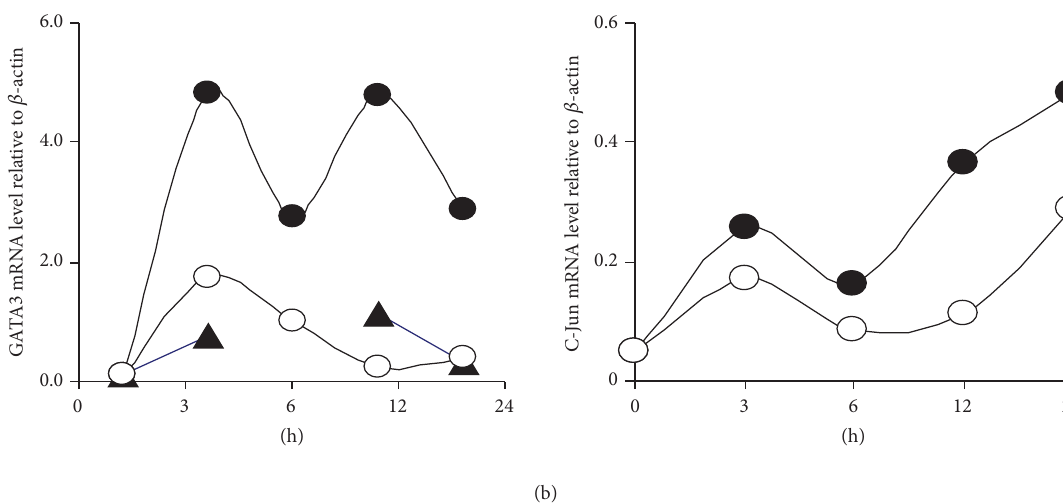
Figure 4: Effect of Periplocin on proinflammatory cytokine expression in splenocytes from Freund’s complete adjuvant Sprague Dawley rats. Splenocytes were prepared as described under Methods. Splenocytes were cultured in the presence or absence of Periplocin or LPS for indicatedtime.ThetotalmRNAwaspreparedforRT-PCRanalysis.(a)ChemicalstructureofPeriplocin,(b)RT-PCRanalysisofinflammatory cytokine genes and related transcription factors, and relative amounts of each cytokine gene level were determined by densitometric analysis. L: LPS; P: Periplocin; e : LPS only; I : LPS + P; 󳵳 : P